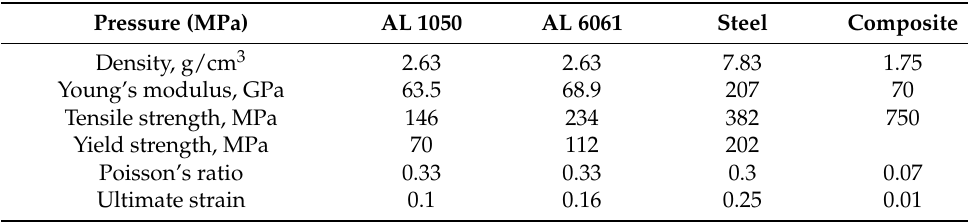
Table 1. Mechanical properties of aluminum, steel, and composite.